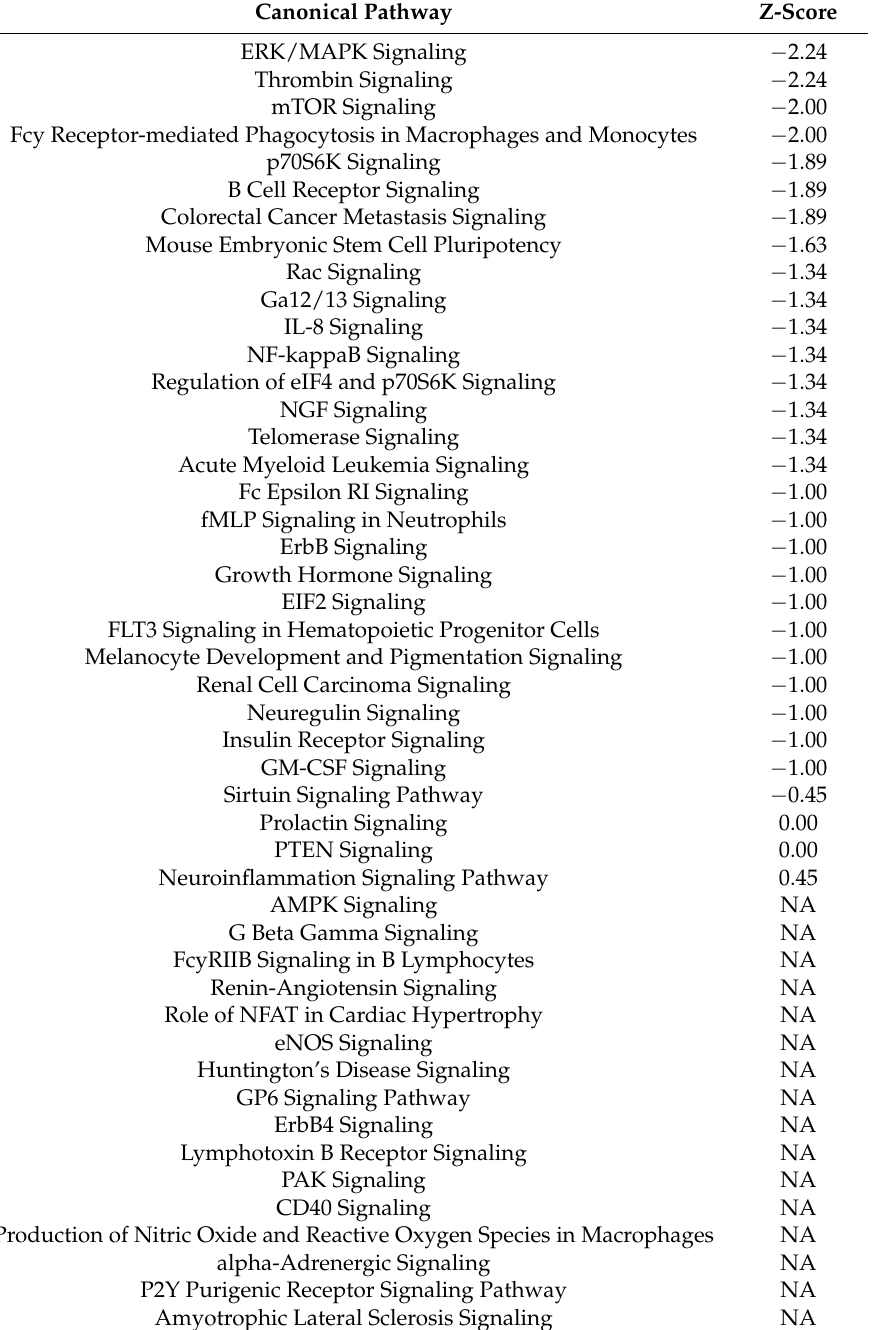
Table 2. Top canonical pathways significantly enriched between treated and non-treated Fayoumis at 10 dpi. Activated pathways are Z-score > 0 and inhibited pathways are Z-score < 0. NA designates pathways without a predicted activity